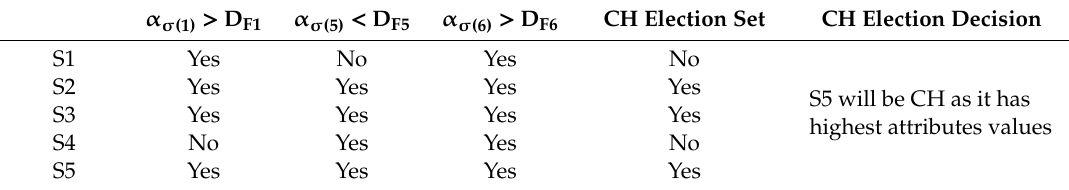
Table 7. Comparison of measured attribute values with threshold attribute values for CH election